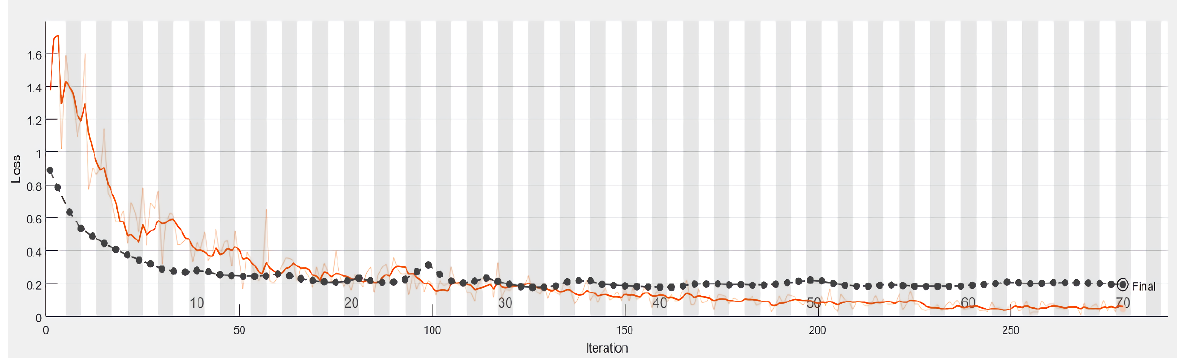
Figure 10. Loss process of the model with the accuracy in the test set (black line) and the training set (blue line).